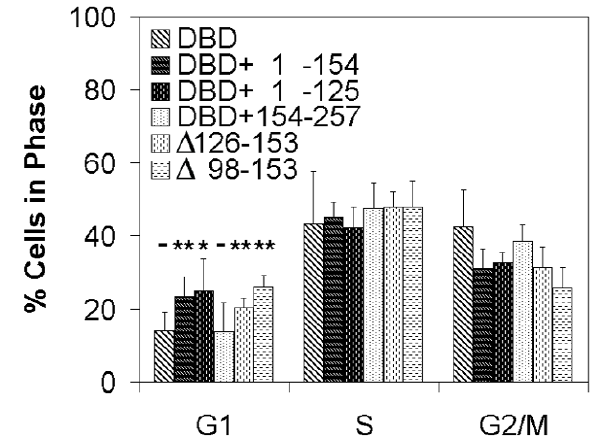
Figure 7 The indicated amino acids of C/EBP α were appended to DBD-GFP (see Fig. 1B) and expressed in GHFT1-5 cells. The proportions of green fluorescent cells in G1, S and M phase in nocodazole-treated cells were determined and plotted as the mean +/- standard deviation from three independent experiments. The DBD + 1–154 mutant was repeated a total six times (not shown), for which the statistical significance remained p < 0.01. Statistically significant increases in the proportion of G1 cells, compared to Sham cells, are indi- cated (One-way ANOVA: ** , p < 0.01; * p < 0.05; -, no differ-